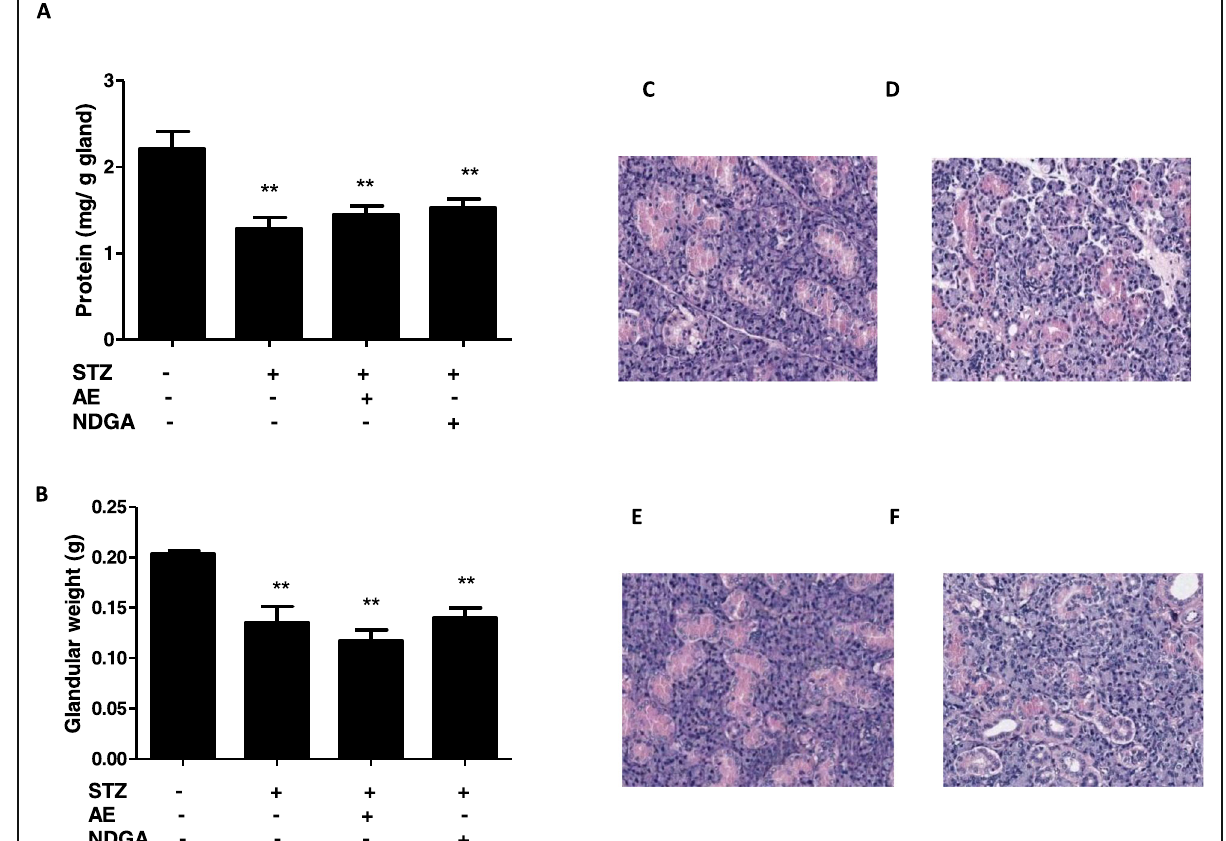
Fig. 3 Effect of AE and NDGA on protein content ( a ) weight ( b ), and histology ( c , d , e , f ) in submandibular glands of streptozotocin-treated female rats. Rats were treated with streptozotocin (STZ) and euthanised on day 10 after treatment. a : The protein concentration was determined on gland homogenates. c , d , e and f : Representative light micrographs (200 X) of rat submandibular glands lobules. Glands were cut, fixed and stained with hematoxylin-eosin. Glands from a control animal ( c ), from a STZ-treated animal ( d ), from a STZ-treated animal + AE ( e ), from a STZ- treated animal + NDGA ( f ). AE: 500 μ g/ml, NDGA: 1.5 μ g/ml. Results represent Mean ± SEM of values from at least five glands. ** P < 0.01 significant differences between submandibular glands from normal control and submandibular glands from STZ- treated animals (Student ’ s t